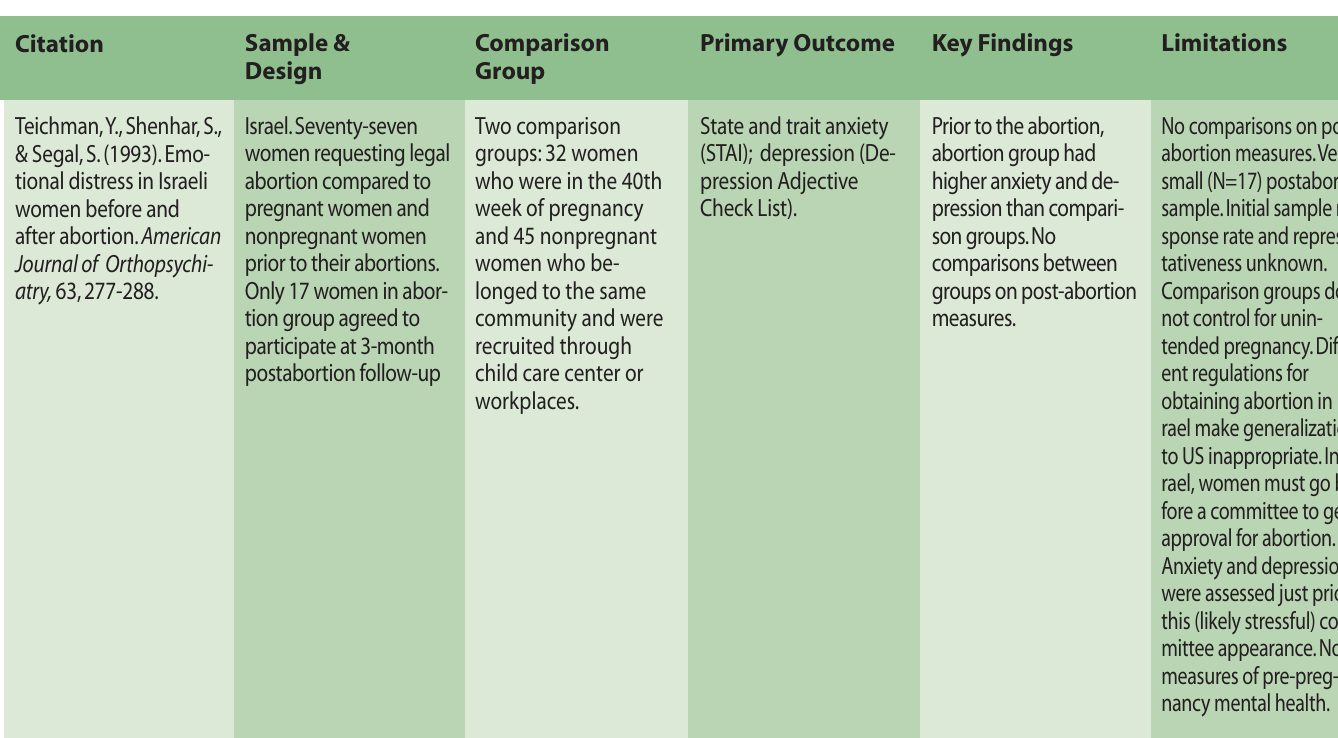
Table 3B: Primary Data Comparison Group Studies NON-U.S.SAMPLES